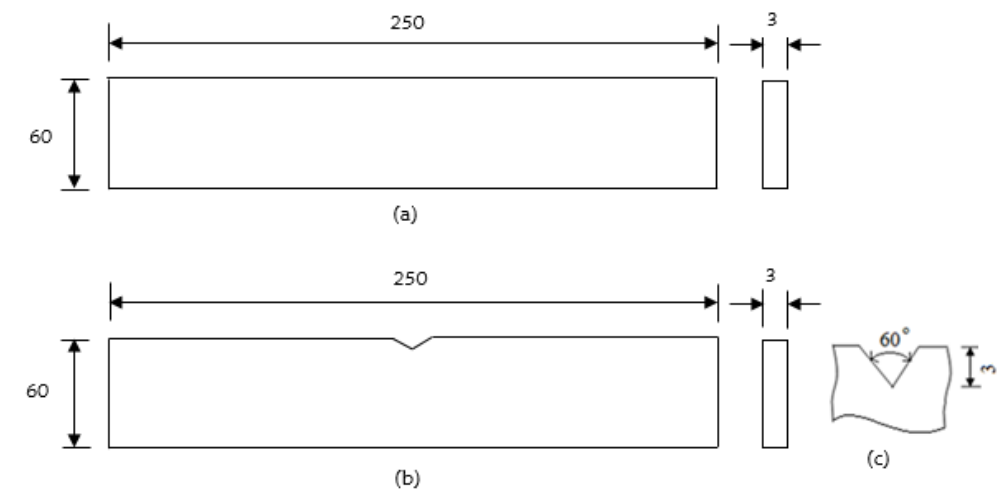
Figure 1: Geometry and dimensions (in millimetre) of the specimens of fabricated hybrid composites (a) For tensile, compressive, and hardness test, (b) notched specimen for impact test and (c) geometry of v-notch.